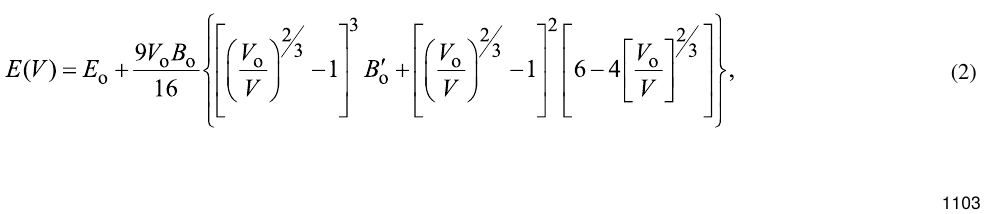
Figure 2: Volume–energy optimization curve of the π -SnSe fitted to the Murnaghan’s equation of state. The relaxed lattice constant is ab = 12.108 Å and the optimized volume is V o = 12658.093 a.u. 3